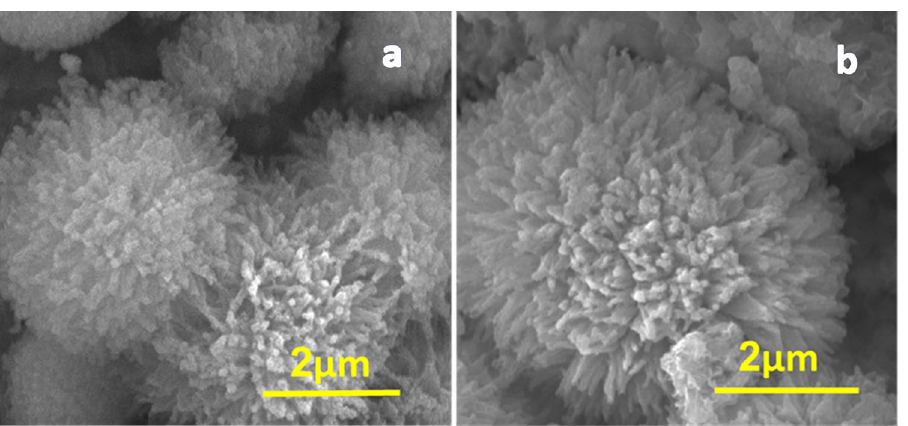
Figure 2. SEM images of NiCo 2 S 4 ( a ) and NiCo 2 S 4 @PPy nanomaterial ( b